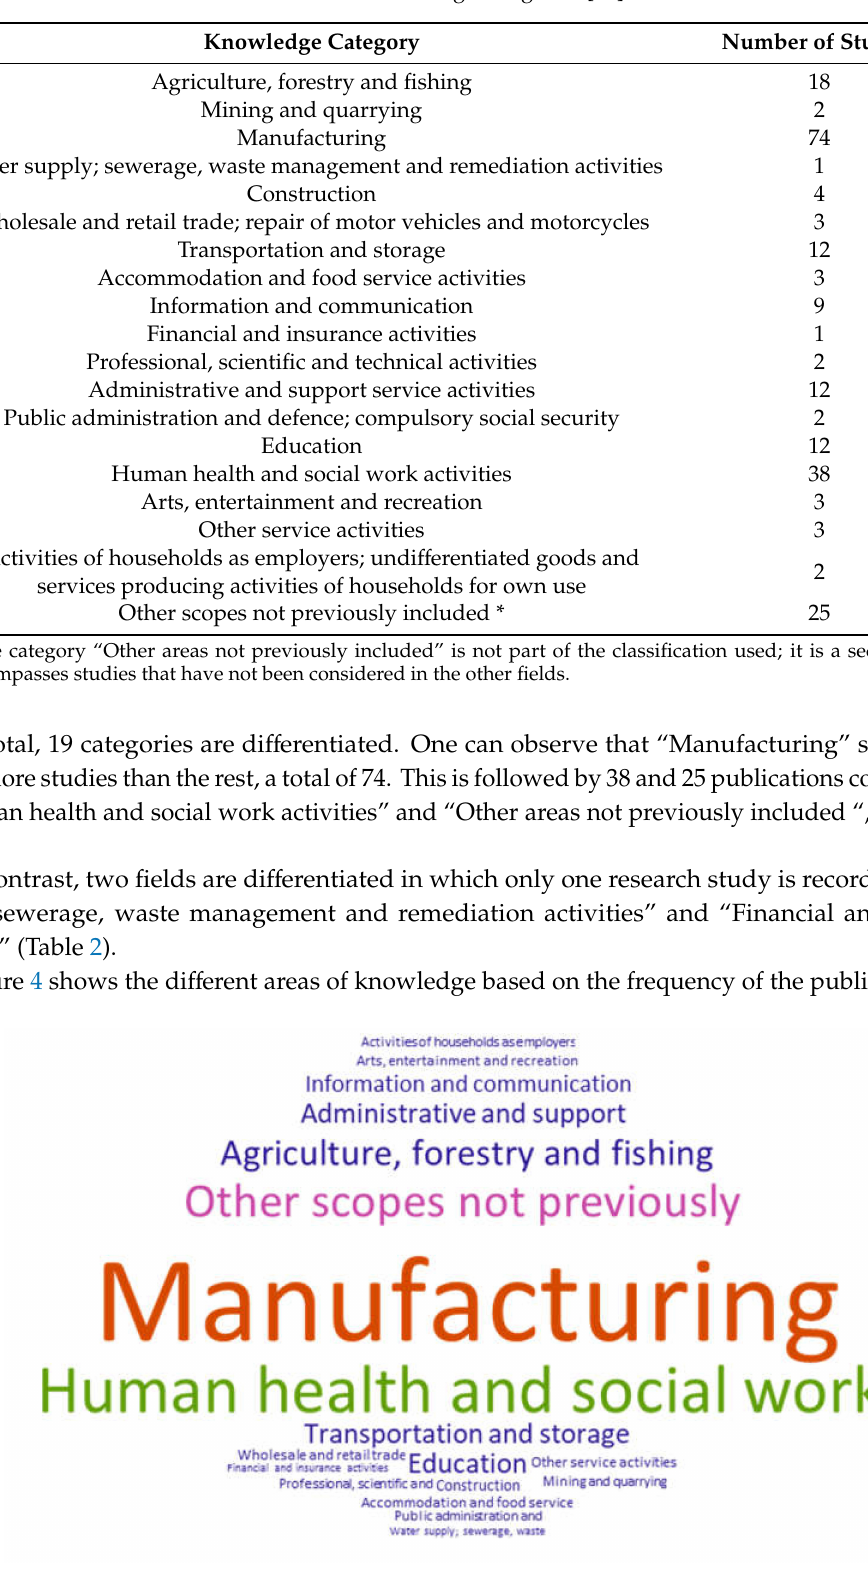
Table 2. Knowledge categories [33].